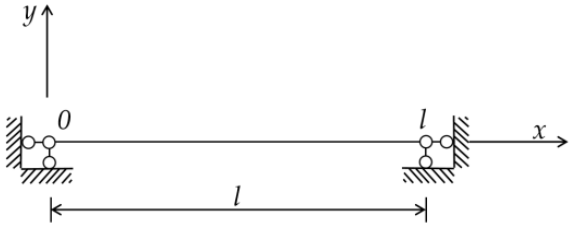
Figure 2. Cable with both ends hinged.